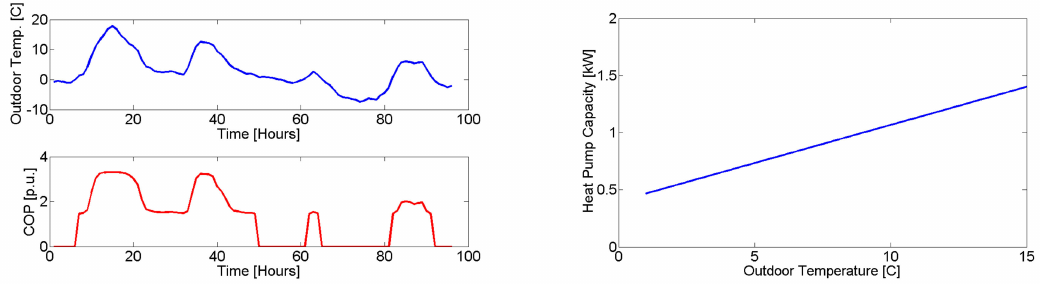
Figure 10. Load following with heat pump and boiler control